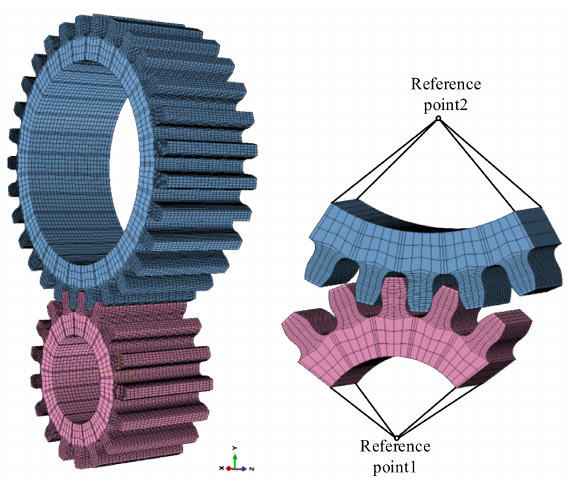
Figure 7. 3D grid model of the modified